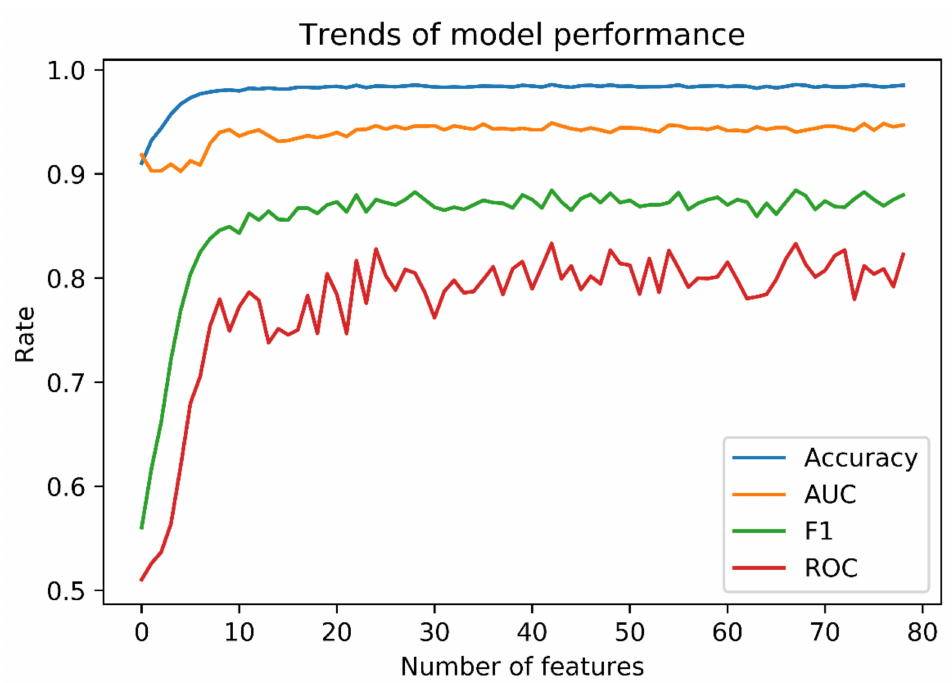
Figure 2. Trends of model performances using di ff erent number of features. As shown in the figure, the performance of model improved as we included more features in the model and it reached a plateau at around 30 features. Therefore, we were able to achieve the similar model performance with much less